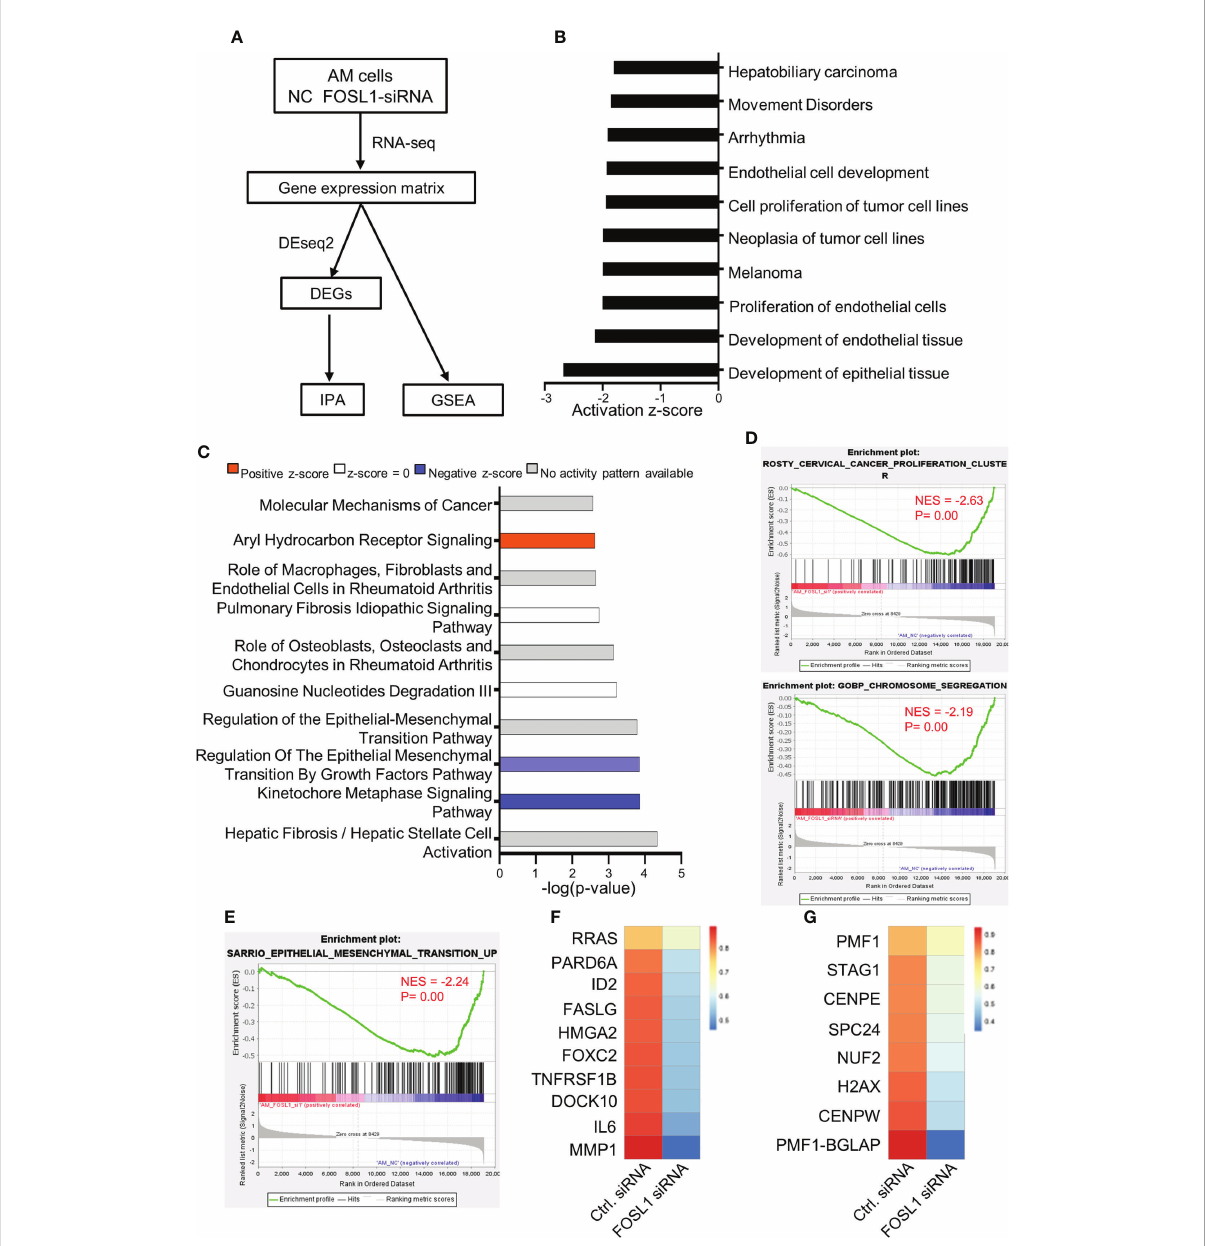
FIGURE 4 Silencing FOSL1 inhibits kinetochore metaphase signaling and the epithelial – mesenchymal transition pathway in AM (A) Flowchart showing the experimental approach of RNA-seq in AM cells. (B, C) IPA showed the biological function (B) and canonical pathways (C) in AMs transfected with EZH2 siRNA. (D) GSEA showed that cell proliferation and cell cycle-associated signatures were inactivated in AM cells treated with FOSL1 siRNAs. NES, normalized enrichment score. (E) GSEA showed that EMT-associated signatures were downregulated in AM cells treated with FOSL1 siRNAs. NES, normalized enrichment score. (F, G) Heatmap showing the gene expression in EMT-associated signatures (F) and cell cycle- associated signatures (G)